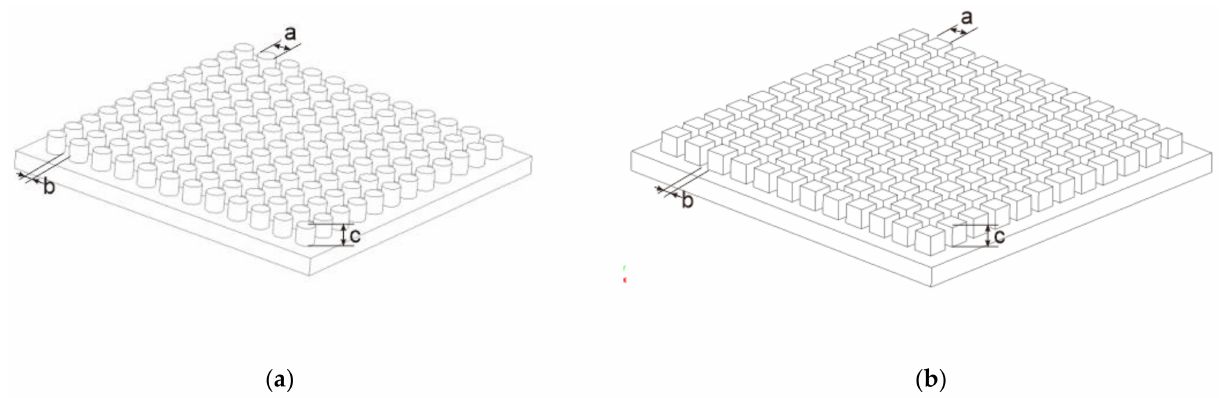
Figure 2. Configuration and dimensions of ( a ) circular and ( b ) rectangular pin fin